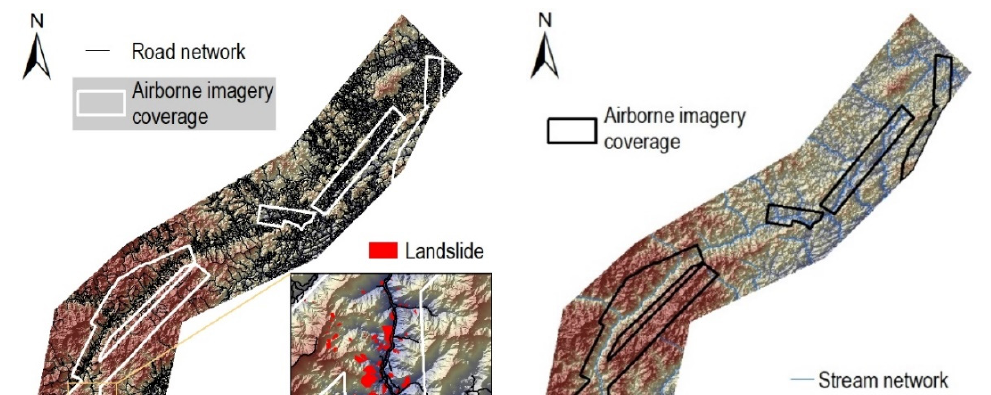
Figure 6. Human activity factors of post ‐ earthquake landslides. ( a ) Road network; ( b ) Stream network.